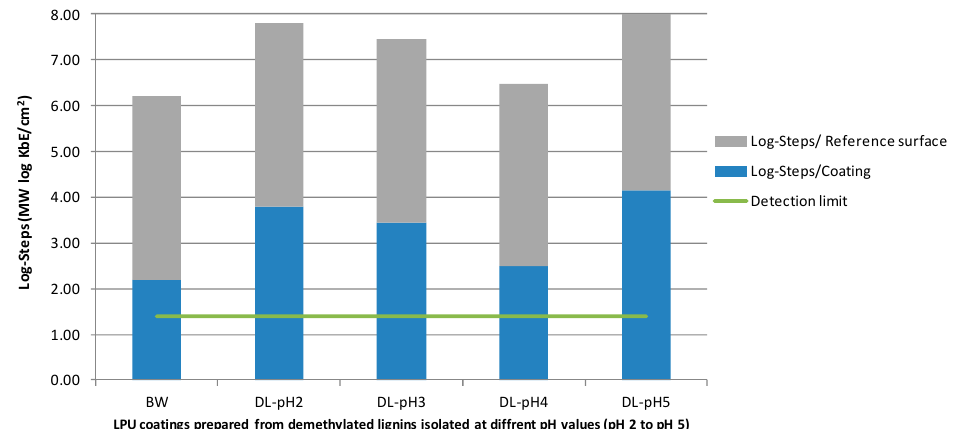
Figure 4. Results of antimicrobial activity against S. aureus of lignin-based PU coatings prepared demethylated lignins (DL) isolated at di ff erent pH values ranging from pH 2 to pH 5. BV:blind value of PU without lignin. The green line represents the detection limit for the determination of the antimicrobial activity (1.4 log Kbe cm − 1 ). Table 5. Antimicrobial activity of lignin and lignin-derived PU coatings against S. aureus . The lignins